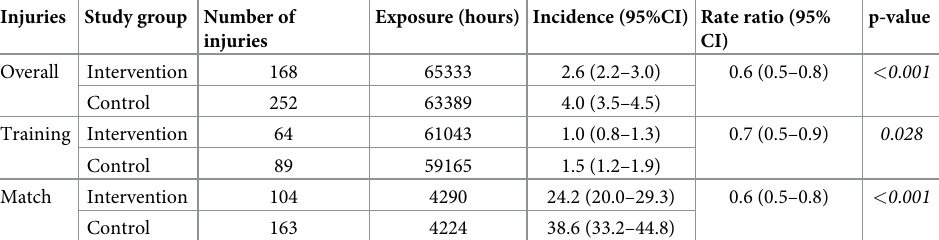
Table 2. Effect of the intervention on the incidence of overall, training and match injuries.